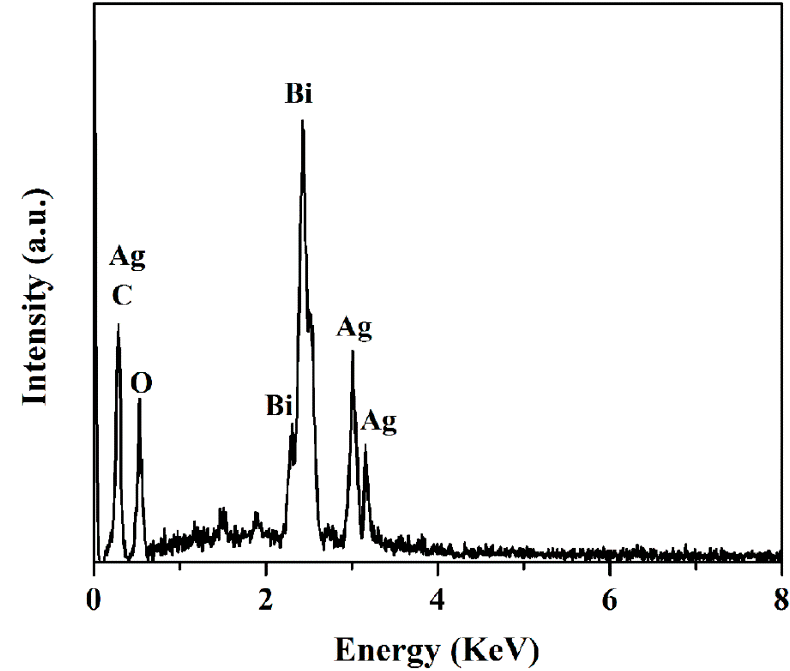
Figure 3. EDS spectra of ACO/BOCH-100.